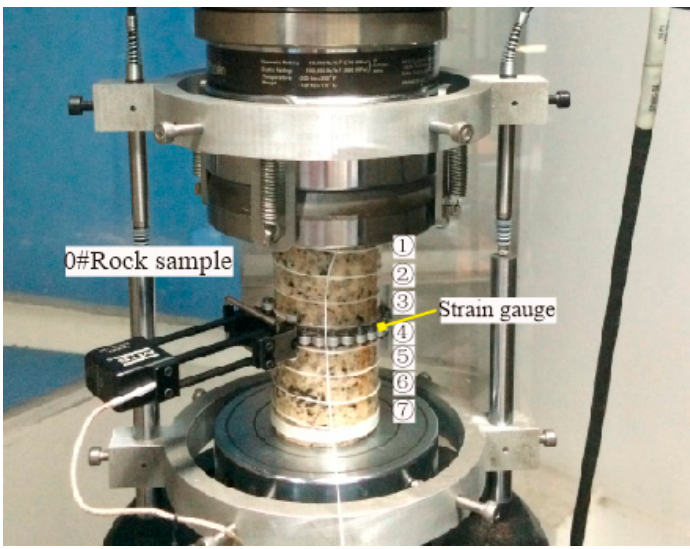
Figure 4. Layout position of the circumferential strain gauge.